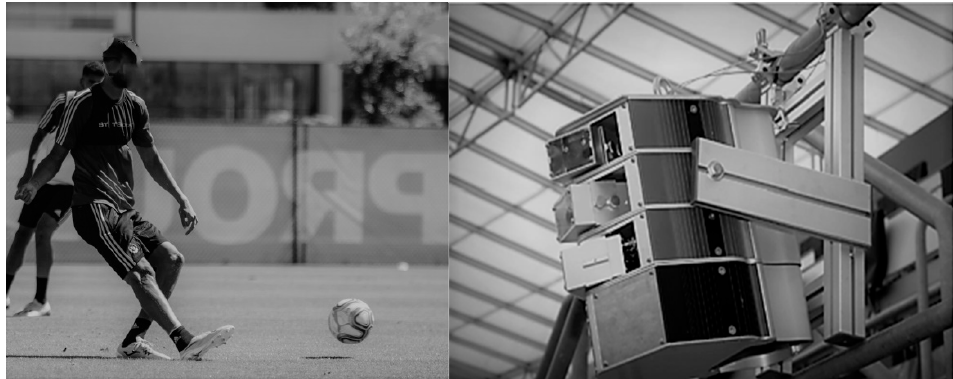
Figure 1. GPS system placed on a player ( left ) and Mediacoach ® cameras in a stadium ( right